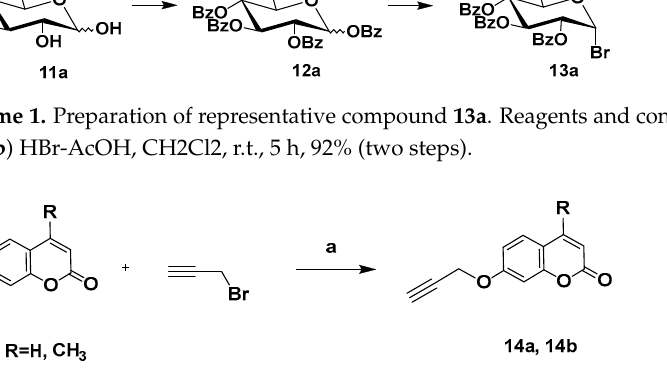
Table 1. One-Pot Synthesis of 15a from benzoyl glycosyl bromide, NaN 3 and alkyne a .